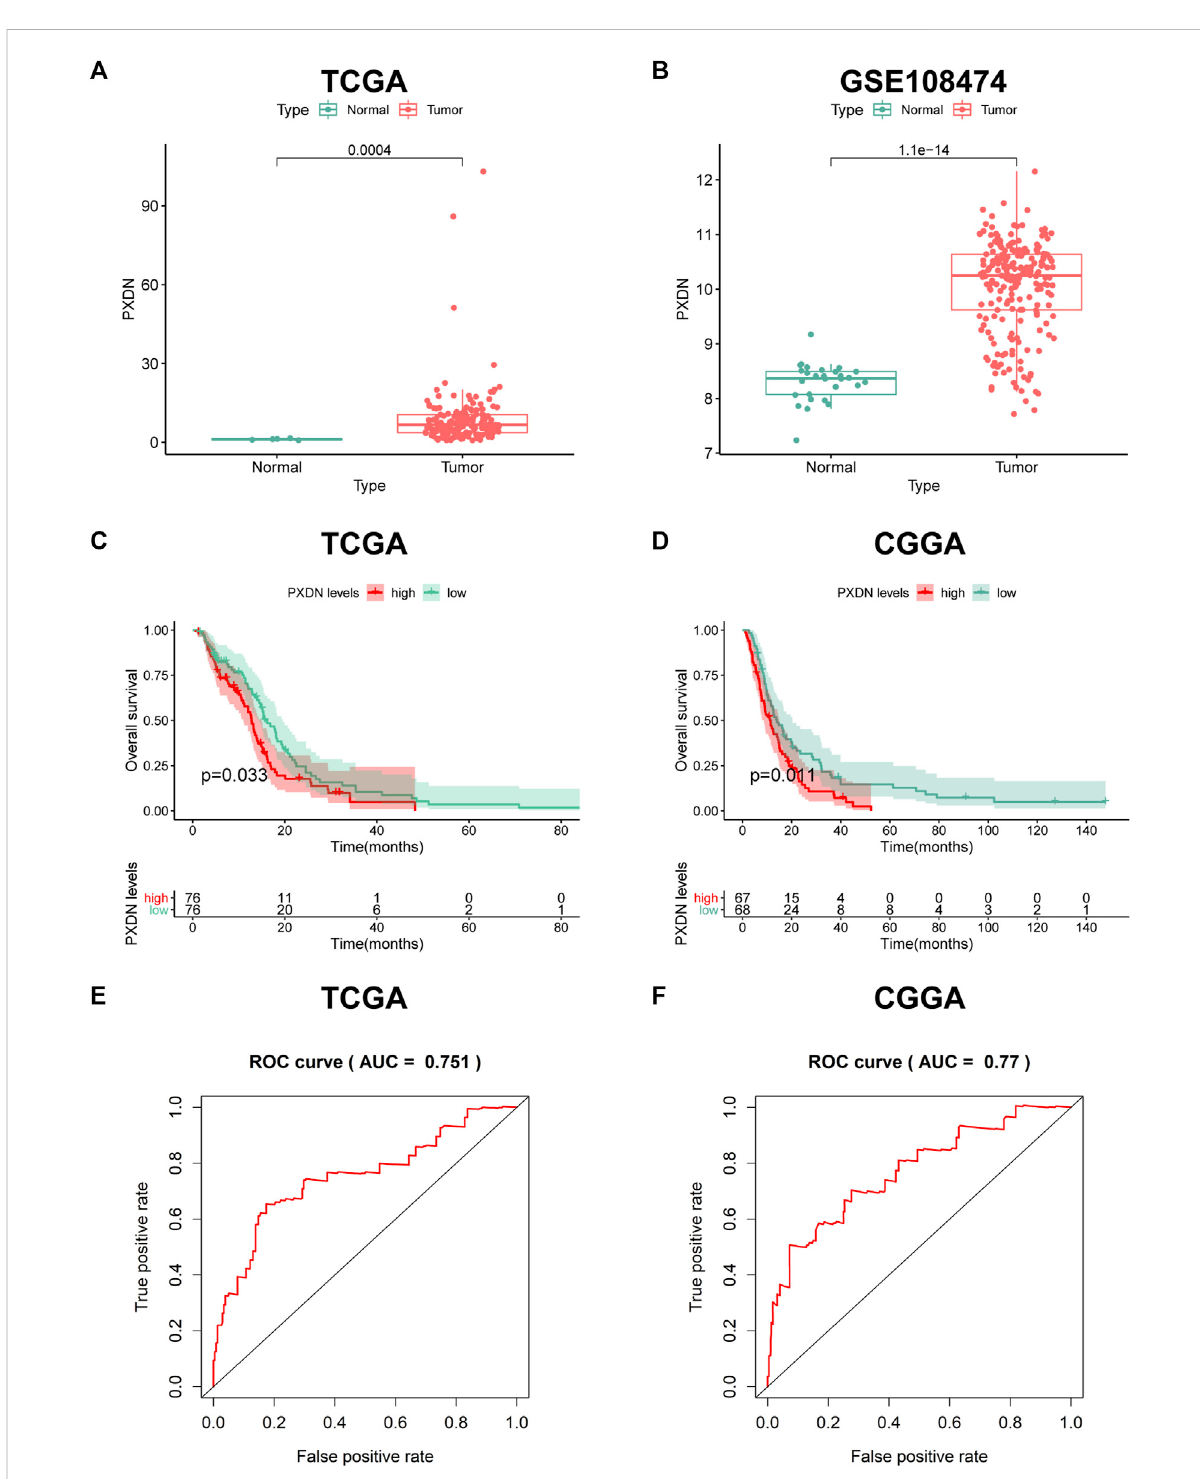
FIGURE 1 Expression pattern and prognosticvalue ofPXDNin GBM. (A,B) Differential PXDN expressionin GBMtissues and normal samples. (C,D) Survival analysis for PXDN based on KM curves. (E,F) ROC curves for assessing the predictive ability of